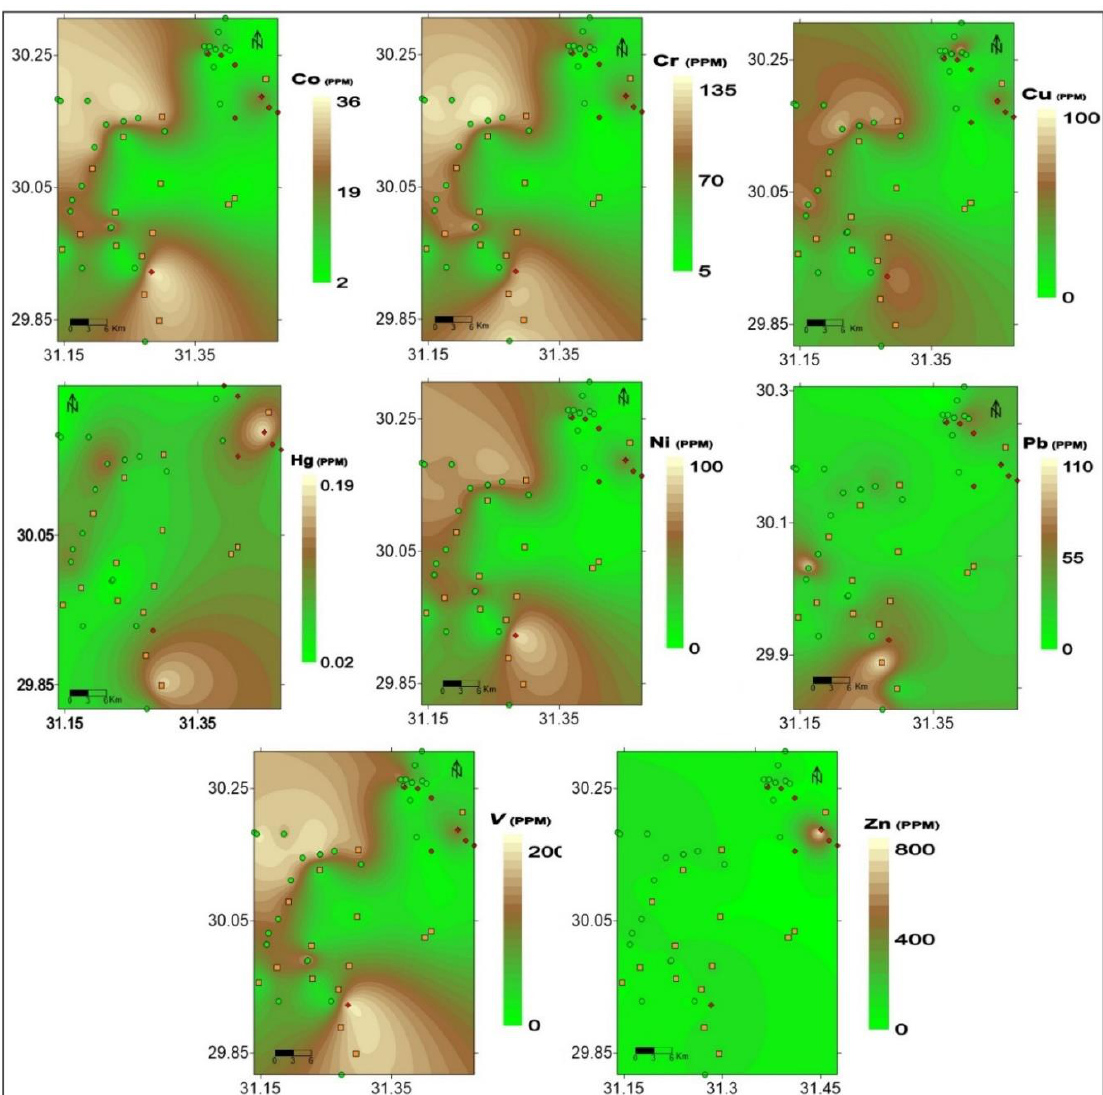
Figure 4. Spatial distribution of